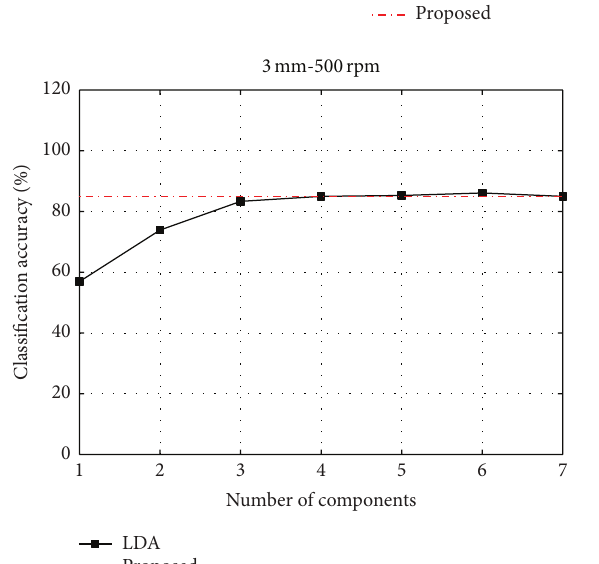
Figure 8: Performance of the proposed feature analysis at a bearing crack size of 3